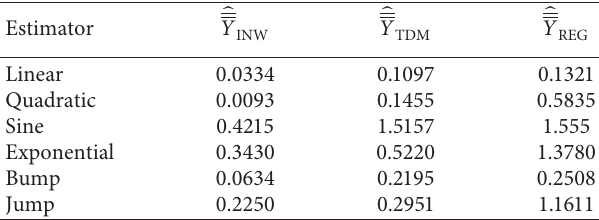
Table 3: Summary results of MSE values.